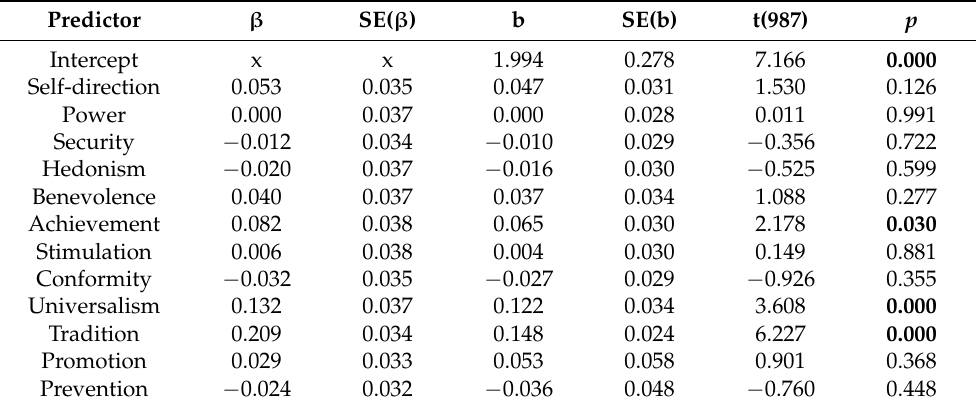
Table 6. The impact of the Schwartz values and regulatory focus on the WTP a price premium for domestic food products in the whole sample without control variables.